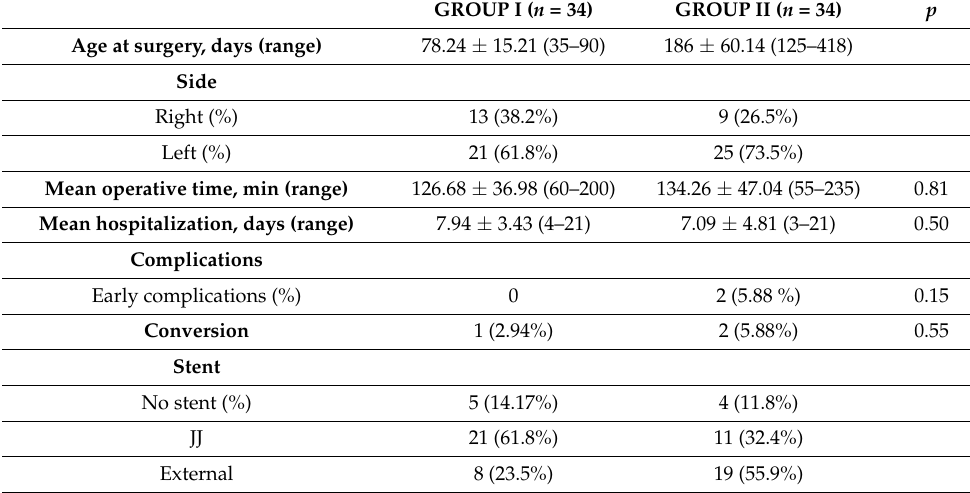
Table 1. Patients’ demographics, and intra- and early post-operative data.